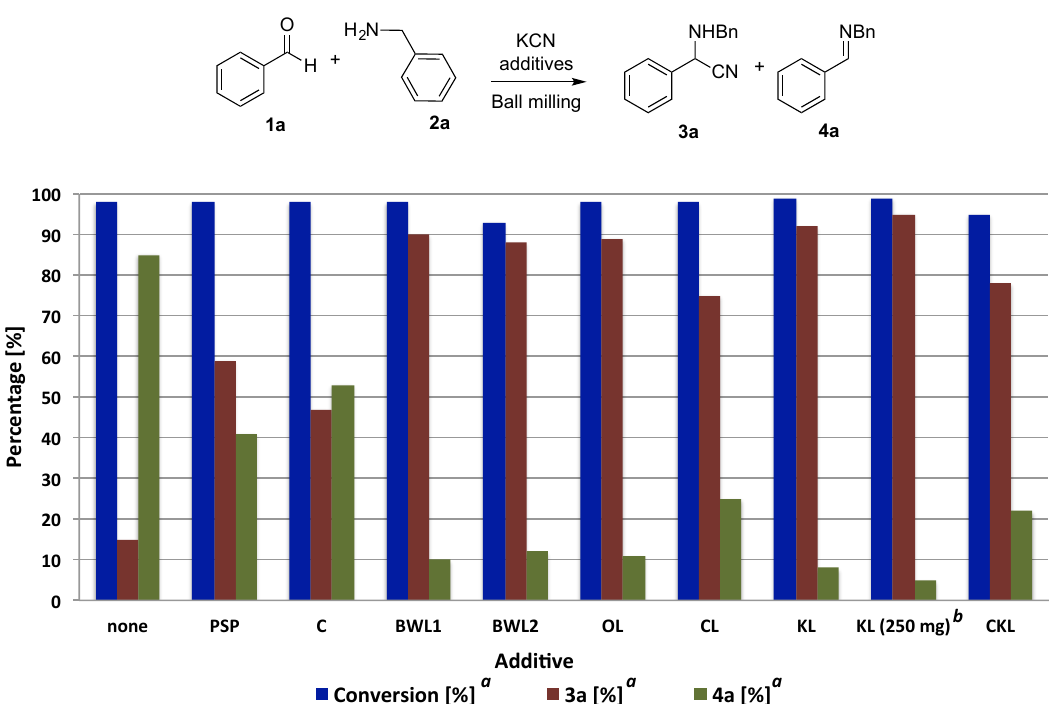
Figure 2. Conversion and selectivity of the mechanochemical Strecker reaction using biomass-derived additives. Reaction conditions: unless otherwise stated, 1a (53.1 mg, 0.5 mmol), 2a (53.6 mg, 0.5 mmol), KCN (35.8 mg, 0.55 mmol), and the additive (200 mg) were milled in a mixer mill for 2 h at 30